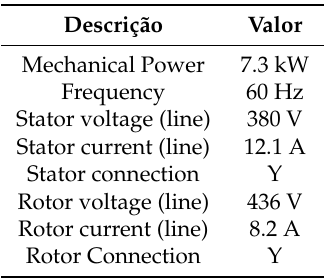
Table 3. DFIG Electrical